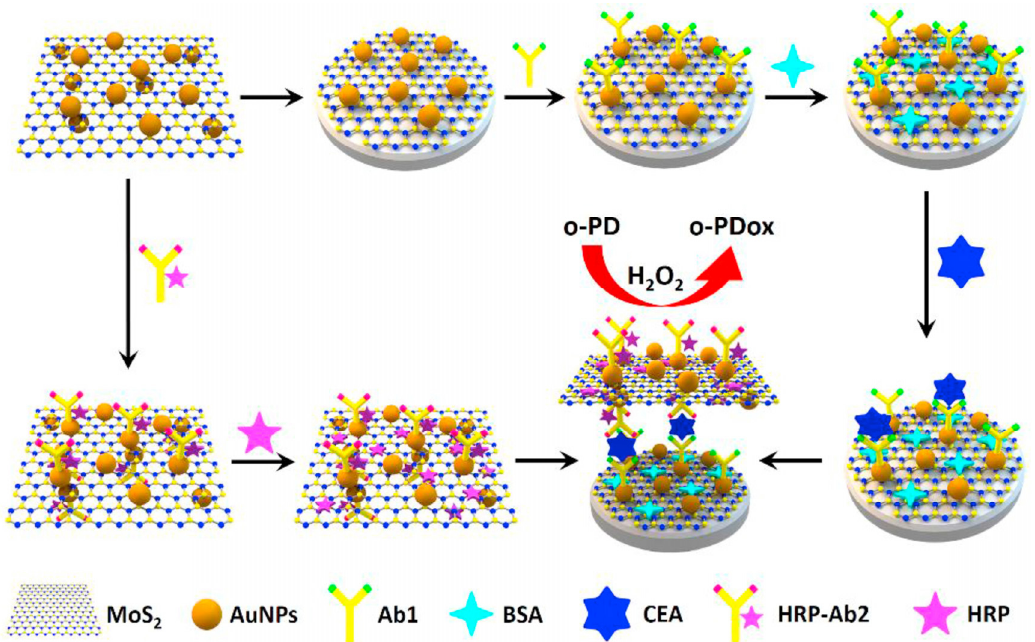
Figure 15. The schematic diagram for the stepwise modification of the GCE with MoS 2 and Au nanoparticles for anti-CEA antibody immobilization for developing a CEA detection sensor. Reprinted with permission from Ref. [81]. Copyright 2019, Elsevier.